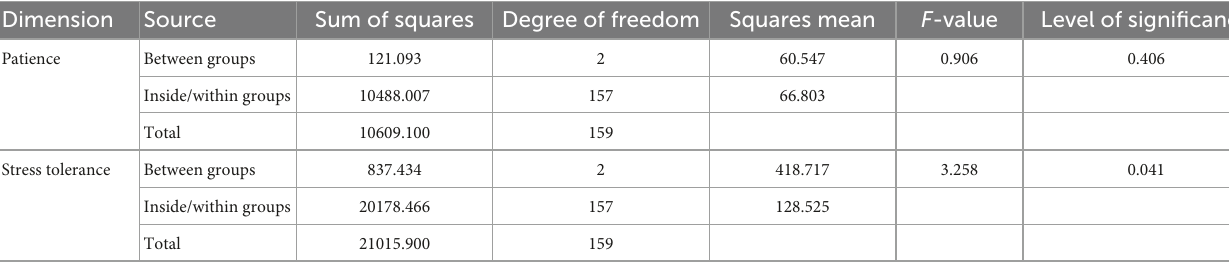
TABLE 7 One way ANOVA analysis of the differences in degree of patience and stress tolerance due to workplace. Dimension